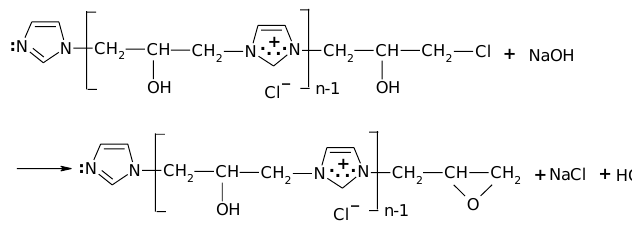
Figure 5. Scheme for creating a reactive form of [IME] + Cl −